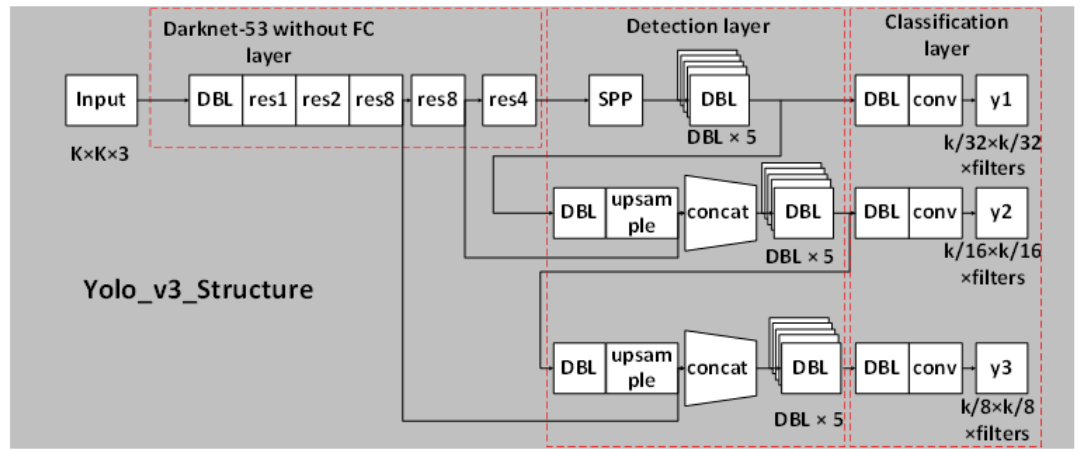
Figure 1. YOLOv3 network structure diagram.